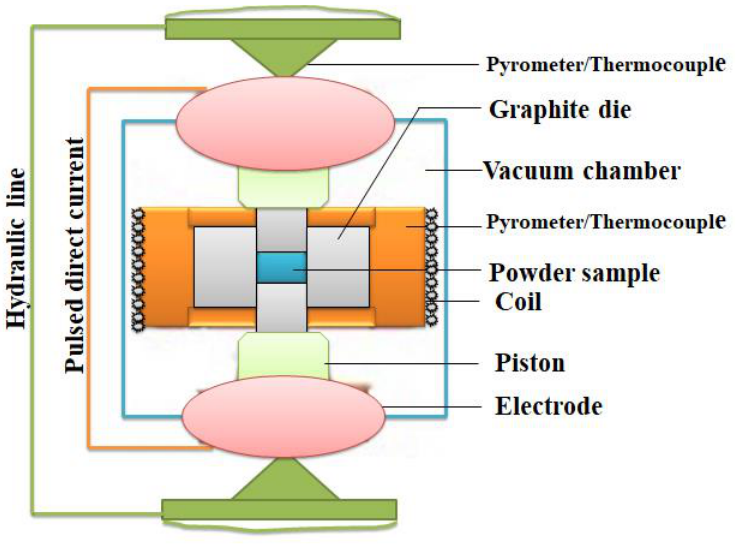
Figure 5. SPS Machine Adapted and Redrawn From [114].